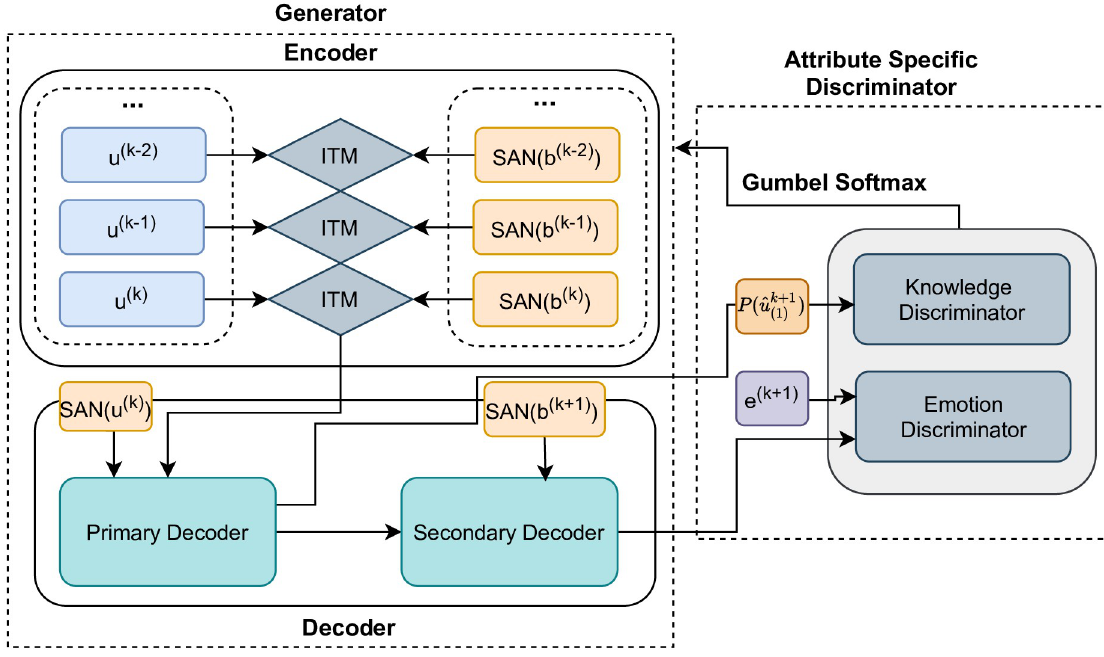
Fig 1. Proposed model architecture. ITM stands for Incremental Transformer Model, SAN stands for Self-Attention Network, variable ‘u’ stands for utterance and ‘b’ stands for knowledge bases.